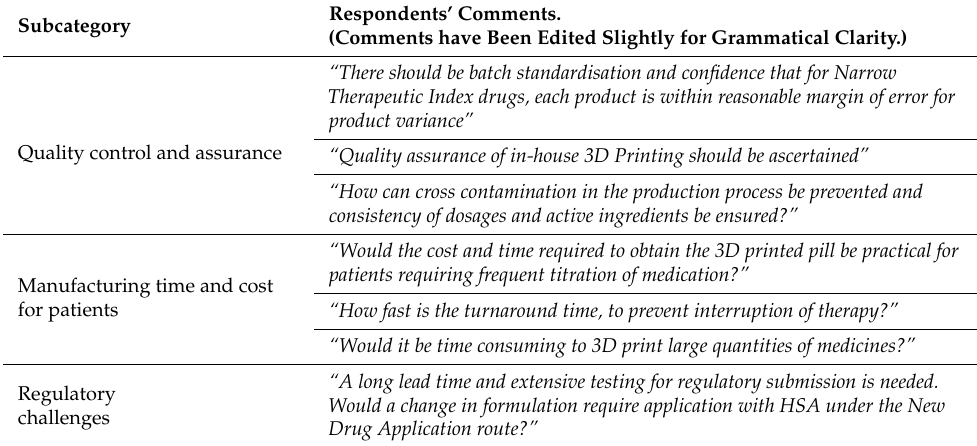
Table 3. Concerns raised by healthcare professionals regarding manufacturing processes.